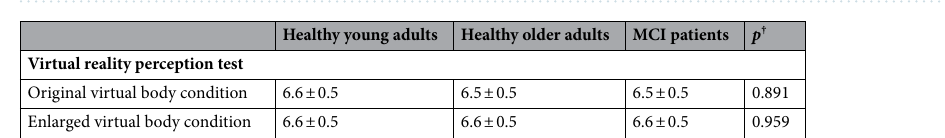
Figure 1. Box plots for virtual reality perception test results by group. ( A ) Original-body action-specific perception. ( B ) Enlarged-body action-specific perception.